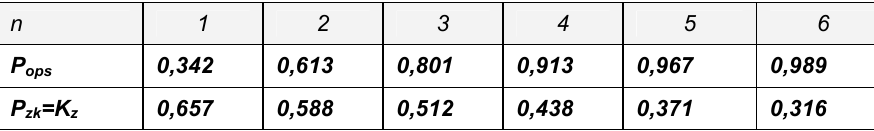
Values of P ops and P zk for different values of